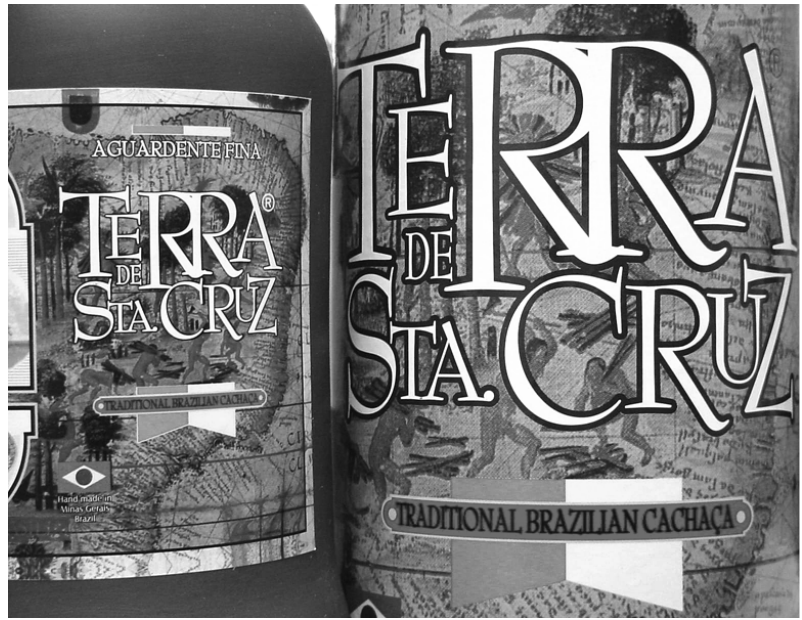
Fig. 4 – Bottle label and the packing of typical Brazilian sugar-cane liquor ( Carta do Brasil , Lopo Homem-Reinéis